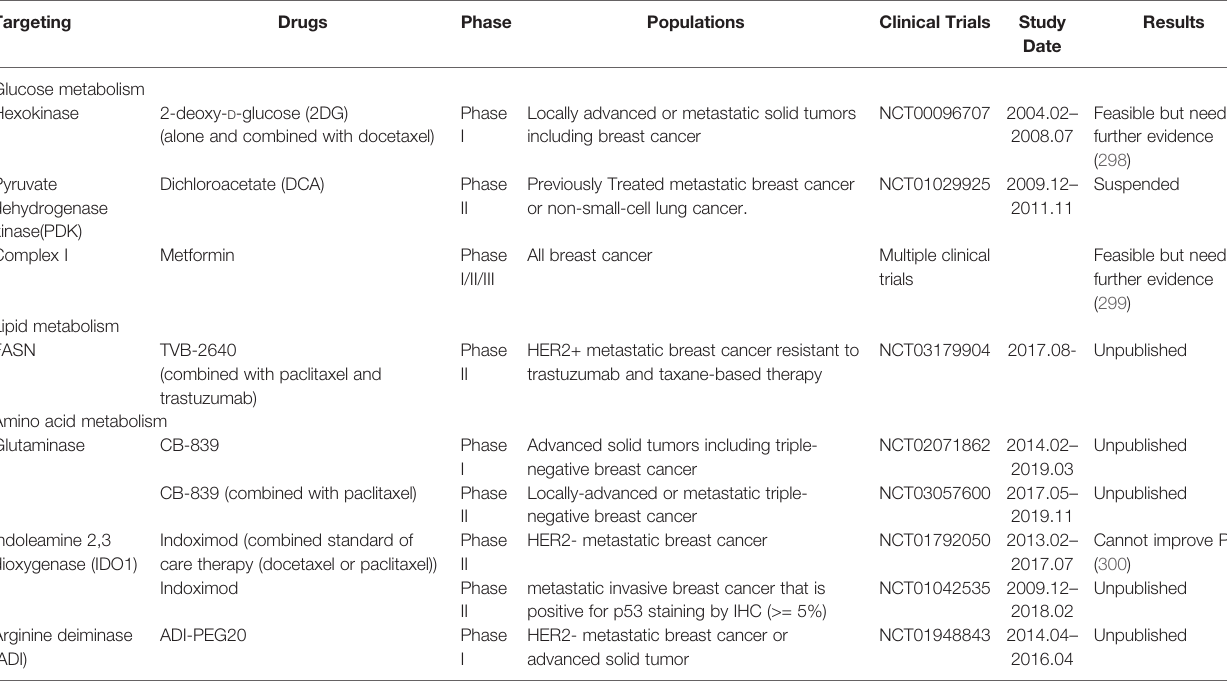
TABLE 2 | Current metabolic interventions in metastatic breast